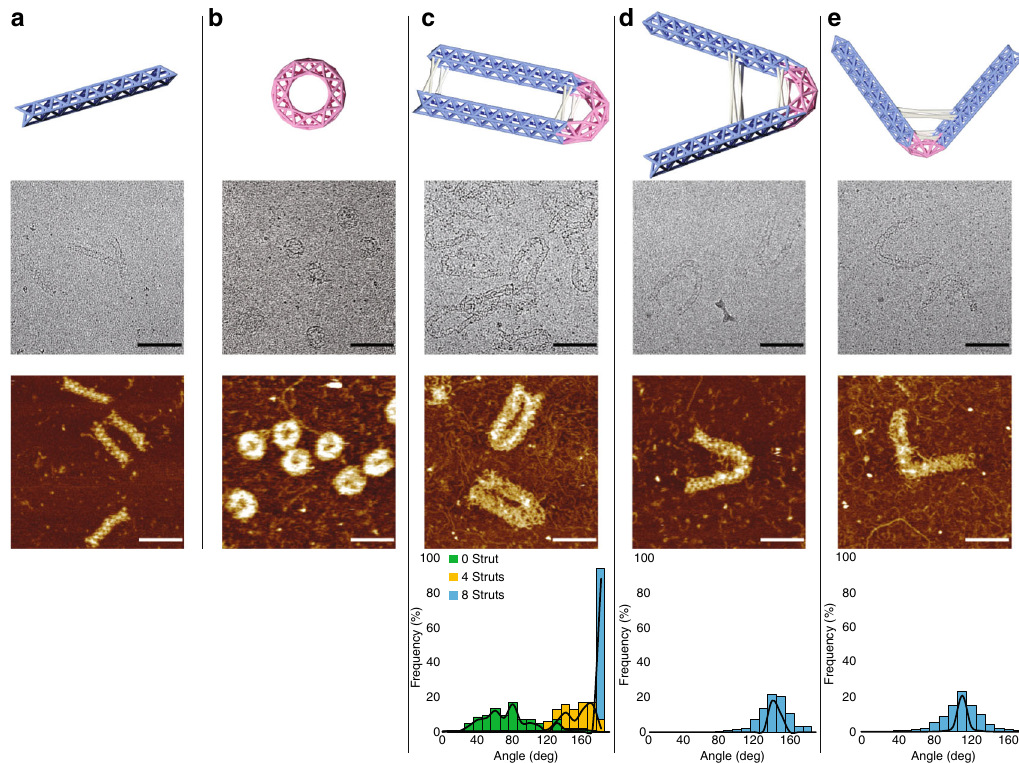
Fig. 3 Wireframe tubes. Schematic diagrams of straight tube ( a ), donut ( b ), U-bent (180°-bent) ( c ), 135°-bent ( d ), and 90°-bent ( e ) tubes on the top row; cryo-EM images (scale bars: 100 nm) on the second row; AFM images (scale bars: 100 nm) on the third row; histograms of bending angles (solid curves represent normal distribution) on the bottom row of c – e